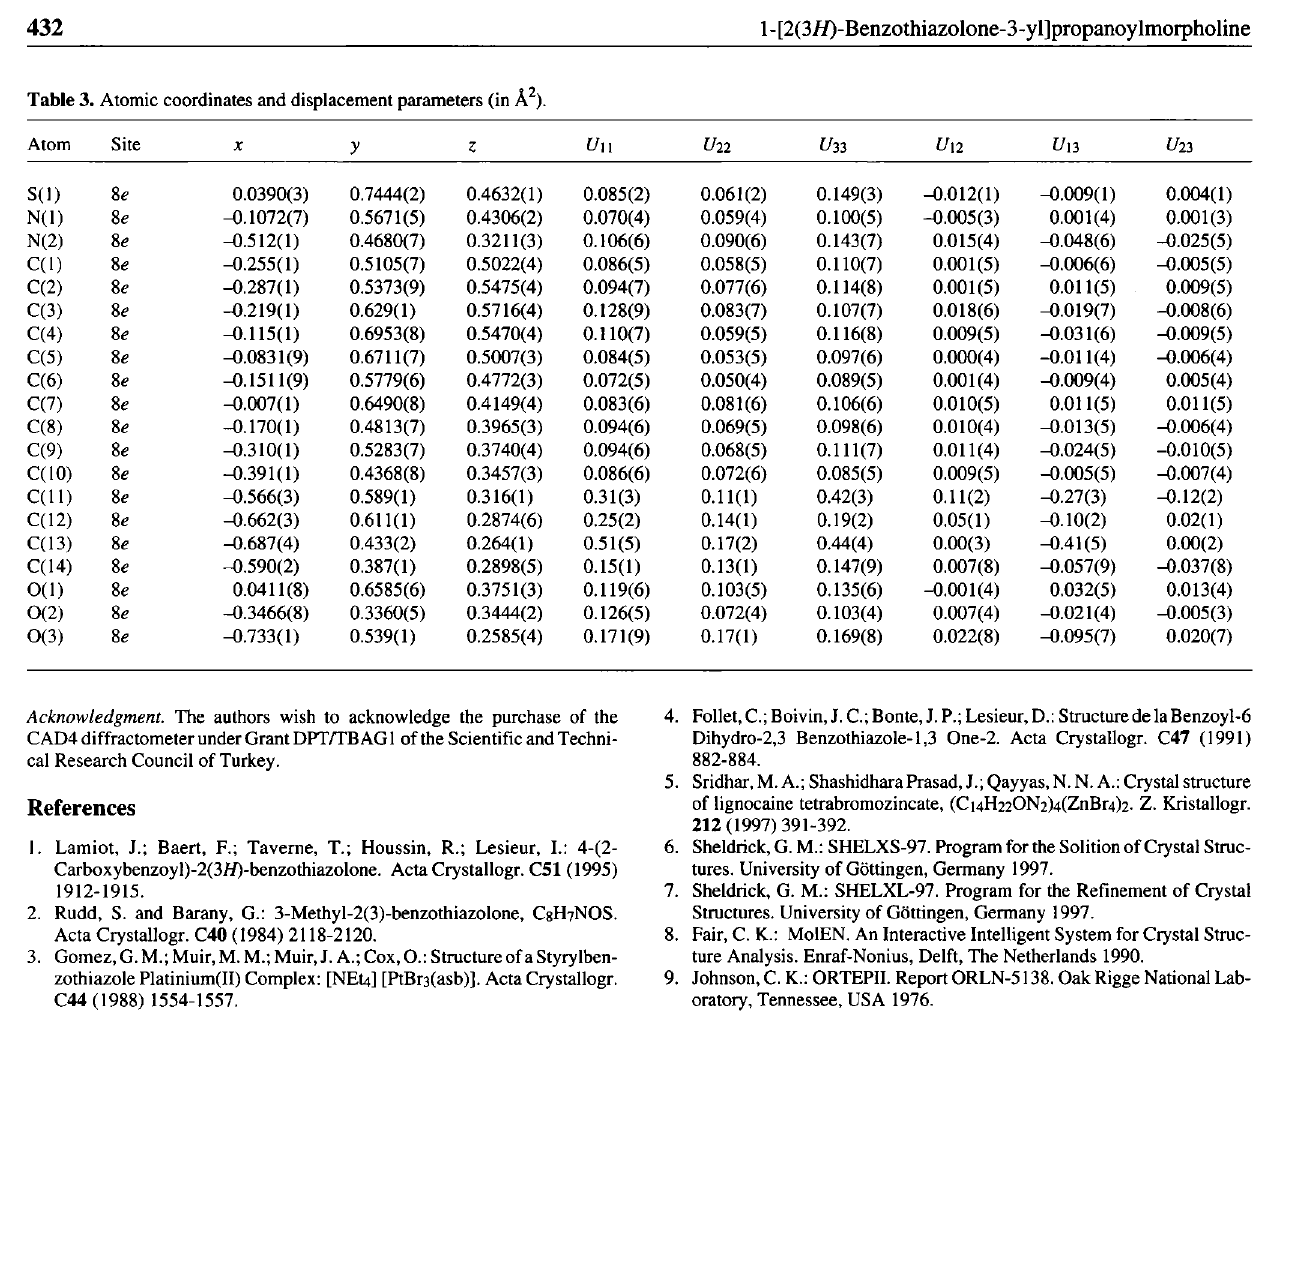
Table 3. Atomic coordinates and displacement parameters (in Ä 2